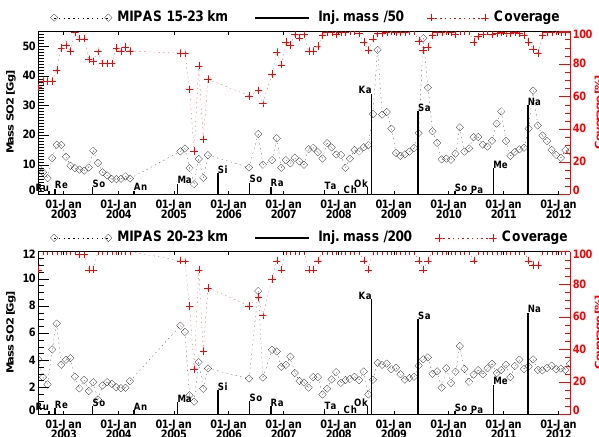
Fig. 13. Black diamonds: global monthly mean SO 2 mass between 15 and 23km (top) and 20–23km (bottom) from MIPAS. Black bars: SO 2 injection mass from Table 2 (scaling factor as given in the legend). Red: relative coverage of the latitude–height slice with MIPAS